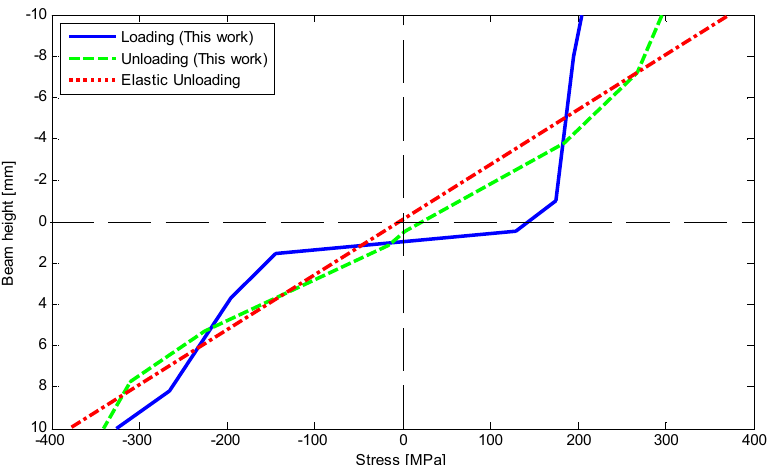
Figure 26. Comparison of stress–height relationship upon loading and unloading with elastic unloading for four-point bending test.